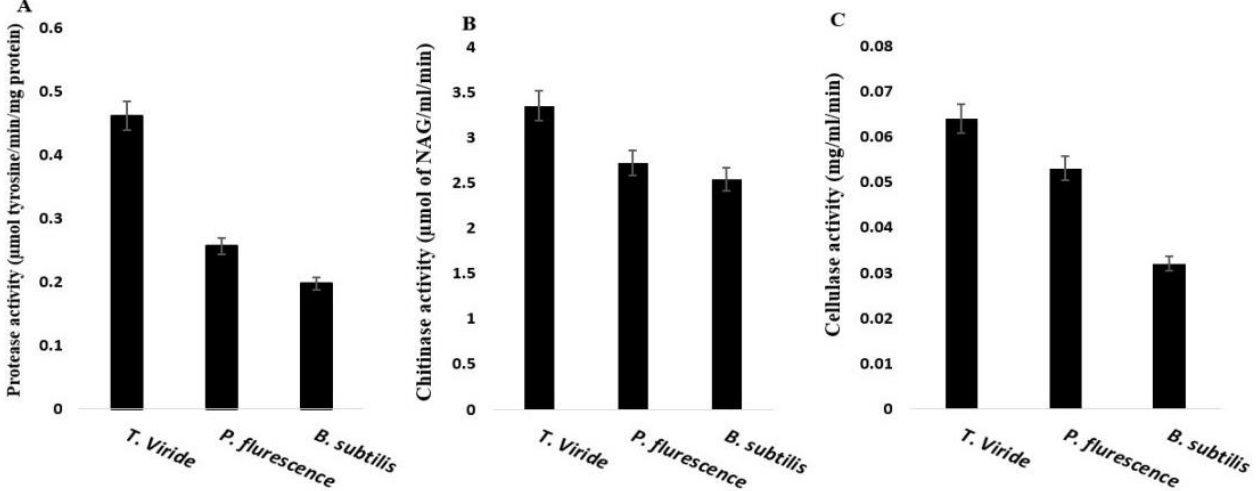
Figure 5. Production of cell-wall degrading enzymes; ( A ) cellulase, ( B ) chitinase, ( C ) protease of T. viride , P. fluorescence , and B. subtilis. Values presented as the means ± the standard deviation of five replicates.